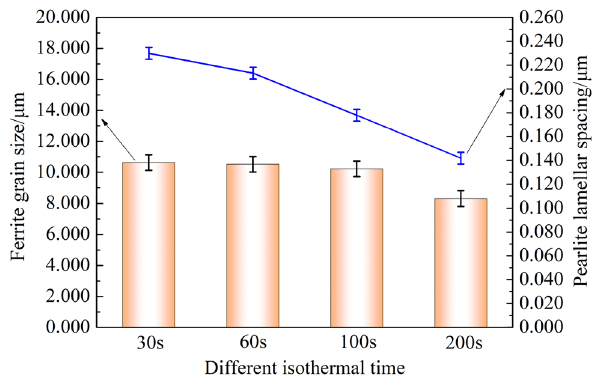
Figure 5: Ferrite grain size and pearlite lamellar spacing of the experimental rebar under the conditions of di ff erent isothermal times.